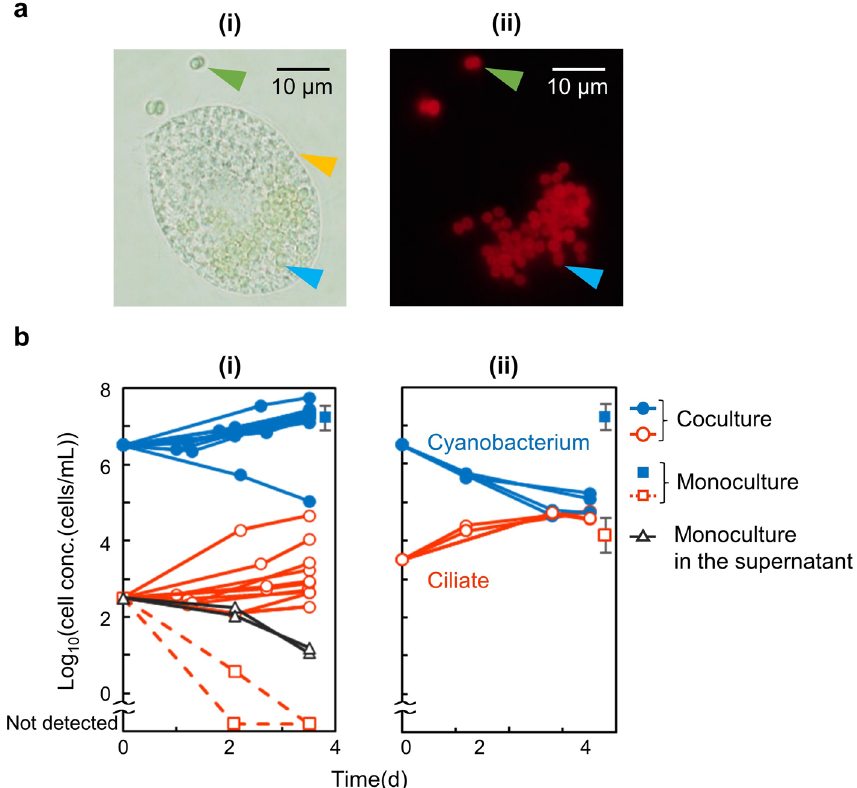
Figure 2. Interactions between the cyanobacterium and ciliate. ( a ) Representative micrographs of a ciliate cell that has taken up cyanobacterial cells. We sampled from a 26-h coculture, at initial concentrations of 10 4 cells/mL ciliate and 10 8 cells/mL cyanobacterium. Conditions of higher cell concentration were set, to easily observe the ciliates under the microscope. ( i ) A micrograph in bright field. ( ii ) A micrograph in fluorescence field. Red particles indicate autofluorescence derived from cyanobacterial chlorophyll. The orange arrow indicates the outline of the ciliate cell. The blue and green arrows indicate the cyanobacterial cells inside and outside the ciliate cell, respectively. ( b ) Cell population dynamics in cocultures. Blue-closed and red-open circles show the cell concentrations of the cyanobacterium and ciliate in the cocultures, respectively. Blue-closed and red-open squares indicate the cell concentrations of the cyanobacterium and the ciliate in monocultures, respectively. For the monoculture results, time courses are shown for the ciliate cell concentration in ( i ), to show the ciliate mortality at low concentration, while mean cell concentration at 3.5 d (the same results as in Fig. 1; for comparison) are shown (at 3.8 days in these graphs) for the other monoculture experiments, i.e., the ciliate in ( ii ) and the cyanobacterium in ( i,ii ). Black-open triangles indicate the cell concentration of the ciliate in monoculture, in which the supernatant of the monoculture of the cyanobacterium was used as the culture